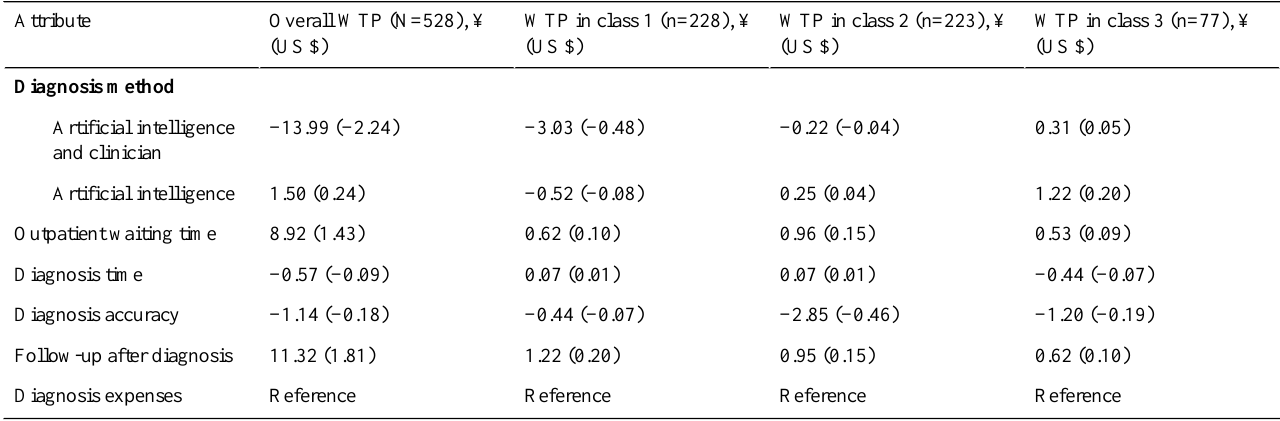
Table 3. Respondents’WTP a in 2017. b